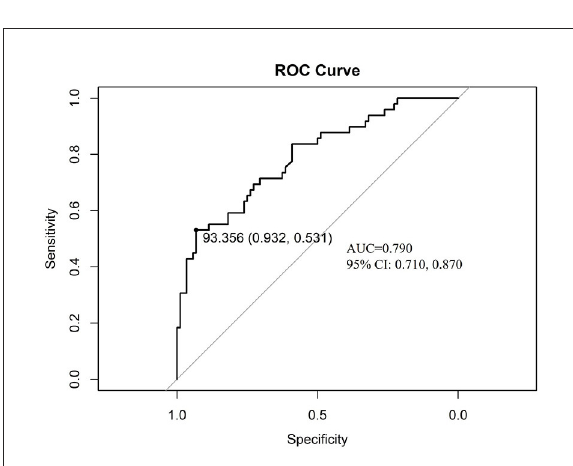
FIGURE6 The discrimination test of nomogram model (ROC analysis). AUC is 0.790 (95%CI: 0.710, 0.870, p < 0.001), the cut-off value is 93.356 point with specificity 0.932 and sensitivity 0.531. ROC: the receiver operating characteristic; AUC: the area under the receiver operating characteristic